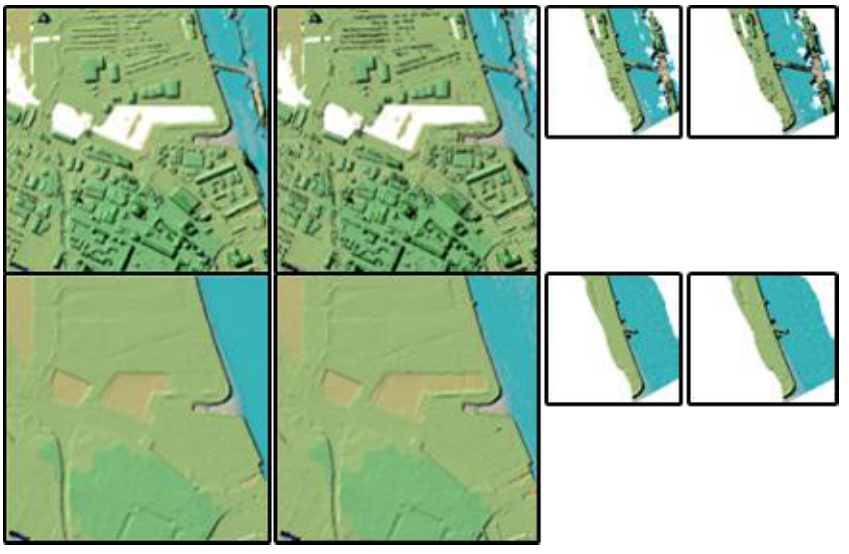
Figure 5. LiDAR DSM ( top ) and DTM ( bottom ) comparison, left to right are 2 m, 1 m, 0.5 m, 0.25 m resolution map